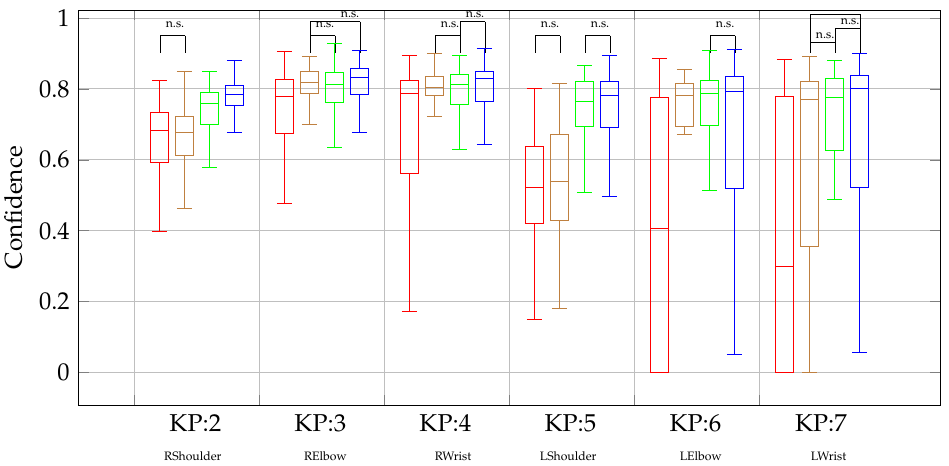
Figure 8. Confidence of detection of selected KP (keypoints). Side view, upper body. Camera views are shown in colour as follows. Lying down (N=215), on the knees (N=92), sitting (N=145) and standing (N=297). All the other differences are statistically significant. Only differences that were not statistically significant (n.s.) are highlighted in the boxplots.